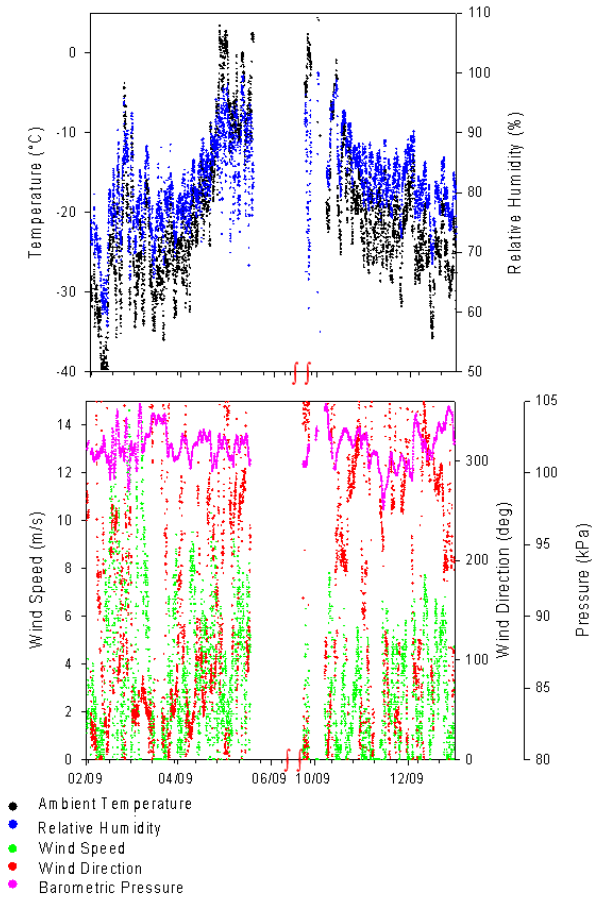
Fig. 8. Plot of the meteorological data acquired on the O-buoy dur- ing 2009. Note, the abscissas have a